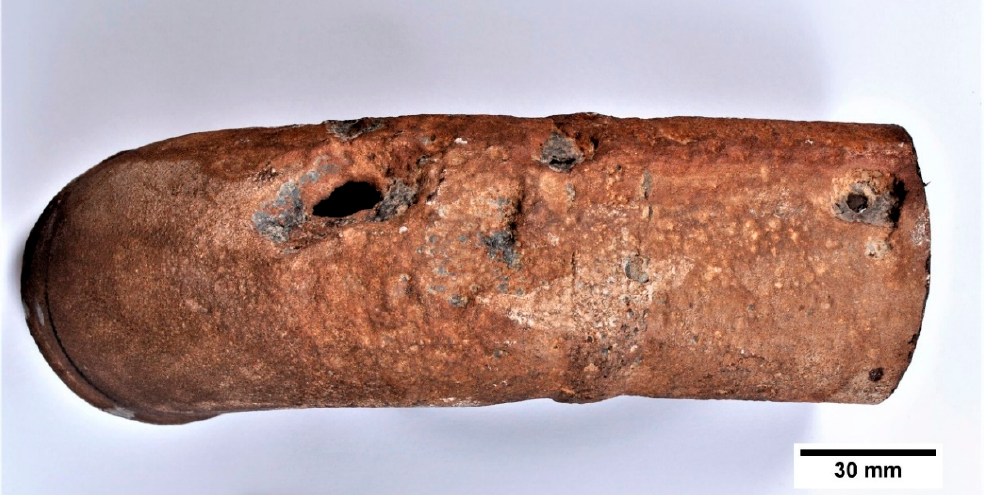
Figure 2. An example of the failed elbows.